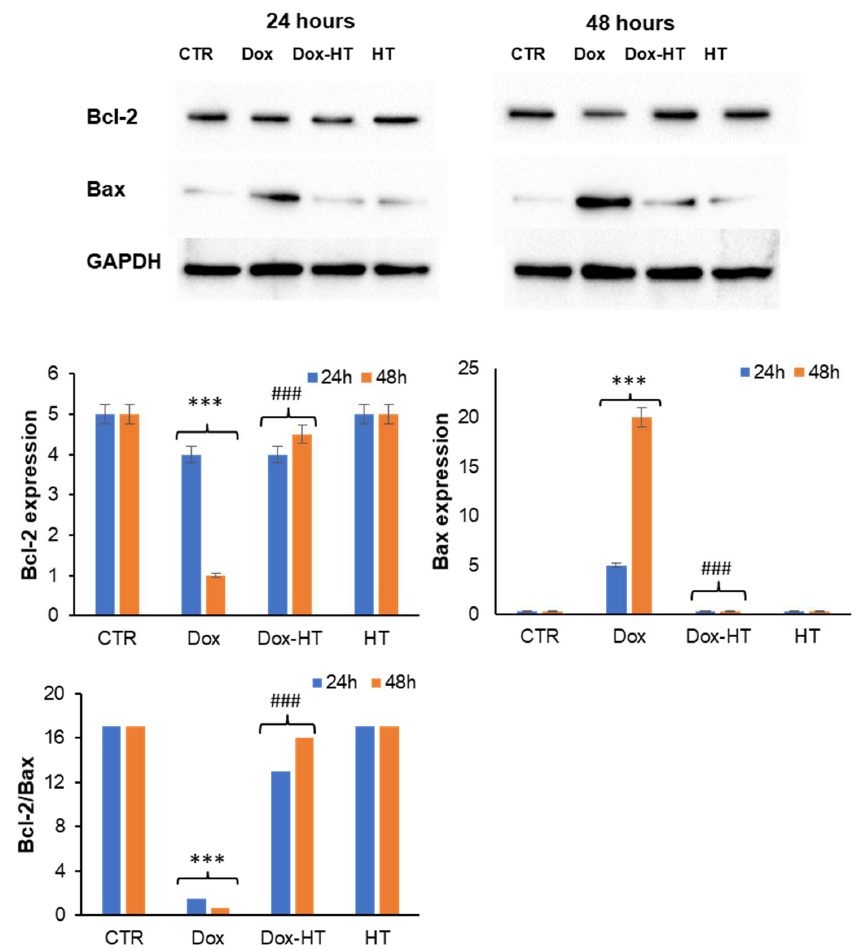
Figure 5. Role of HT in Dox-induced apoptosis. Western blot analysis of Bcl2 and Bax in H9c2 cells exposed to 0.1 µ M Dox (Dox) and co-treated with 50 µ M HT (Dox-HT). CTR: untreated cells. The images are representative of Western blotting from three different cellular extracts with similar results. Other experimental details are described in the Materials and Methods section. *** p < 0.001 versus CTR, ### p < 0.001 versus Dox.